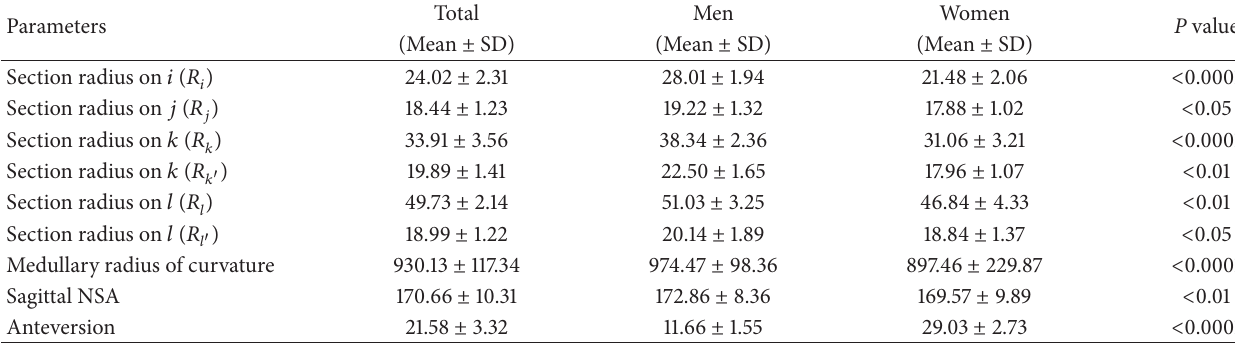
Table 3: Femoral measurements from lateral view (mm;